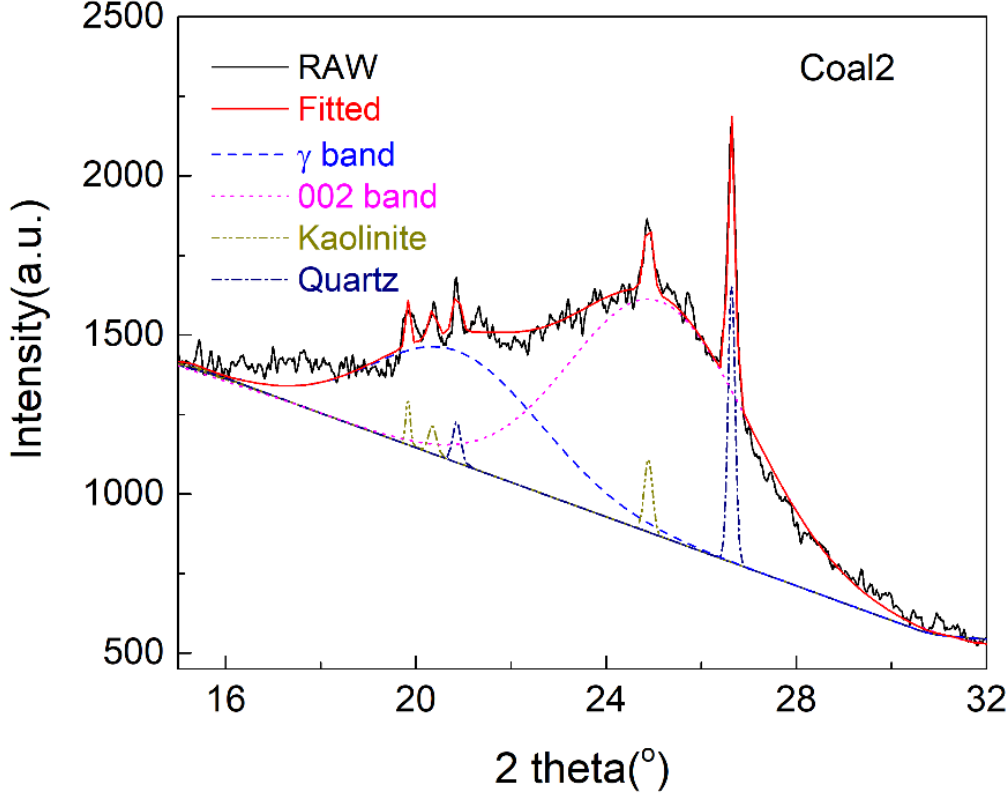
Figure 2. Gaussian curve-fitting of peaks for coal2 in the 2 Theta range of 15–32°.